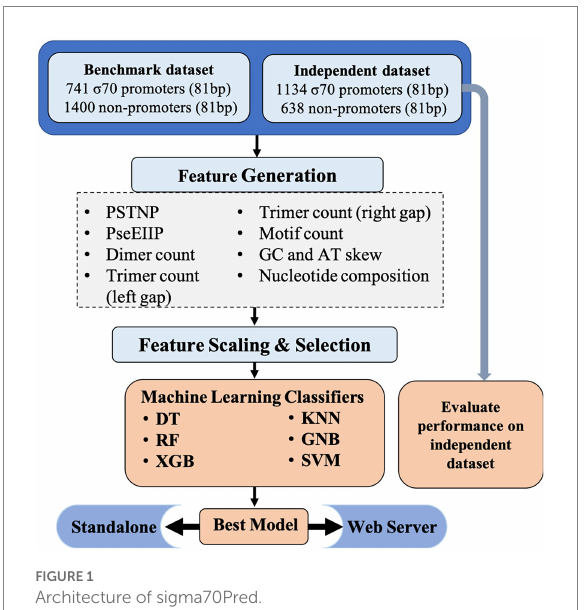
FIGURE 1 Architecture of